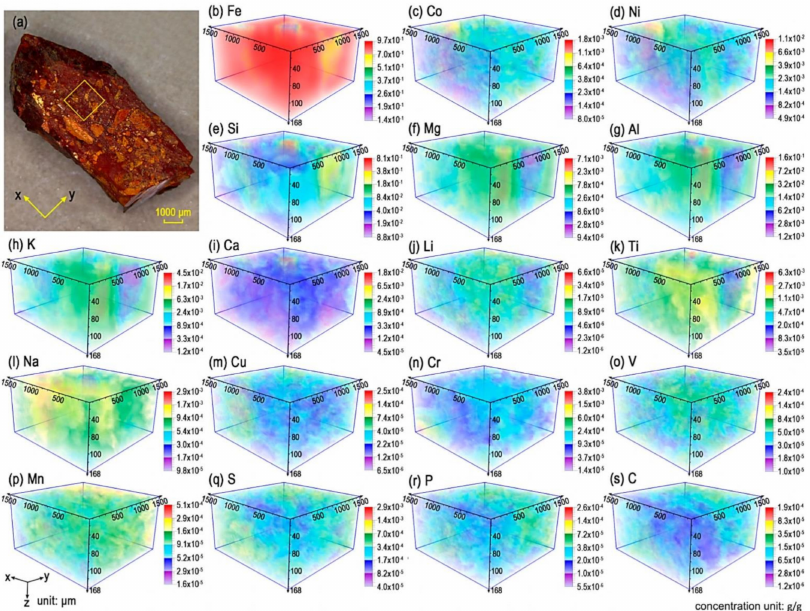
Figure 13. 3D element distributions recorded in the Nantan meteorite. The dimensions of the area are ~1.5 mm 2 . ( a ) Photograph of the meteorite and ( b – s ) particular elemental distributions in the meteorite (g/g in concentration). Reprinted with permission from